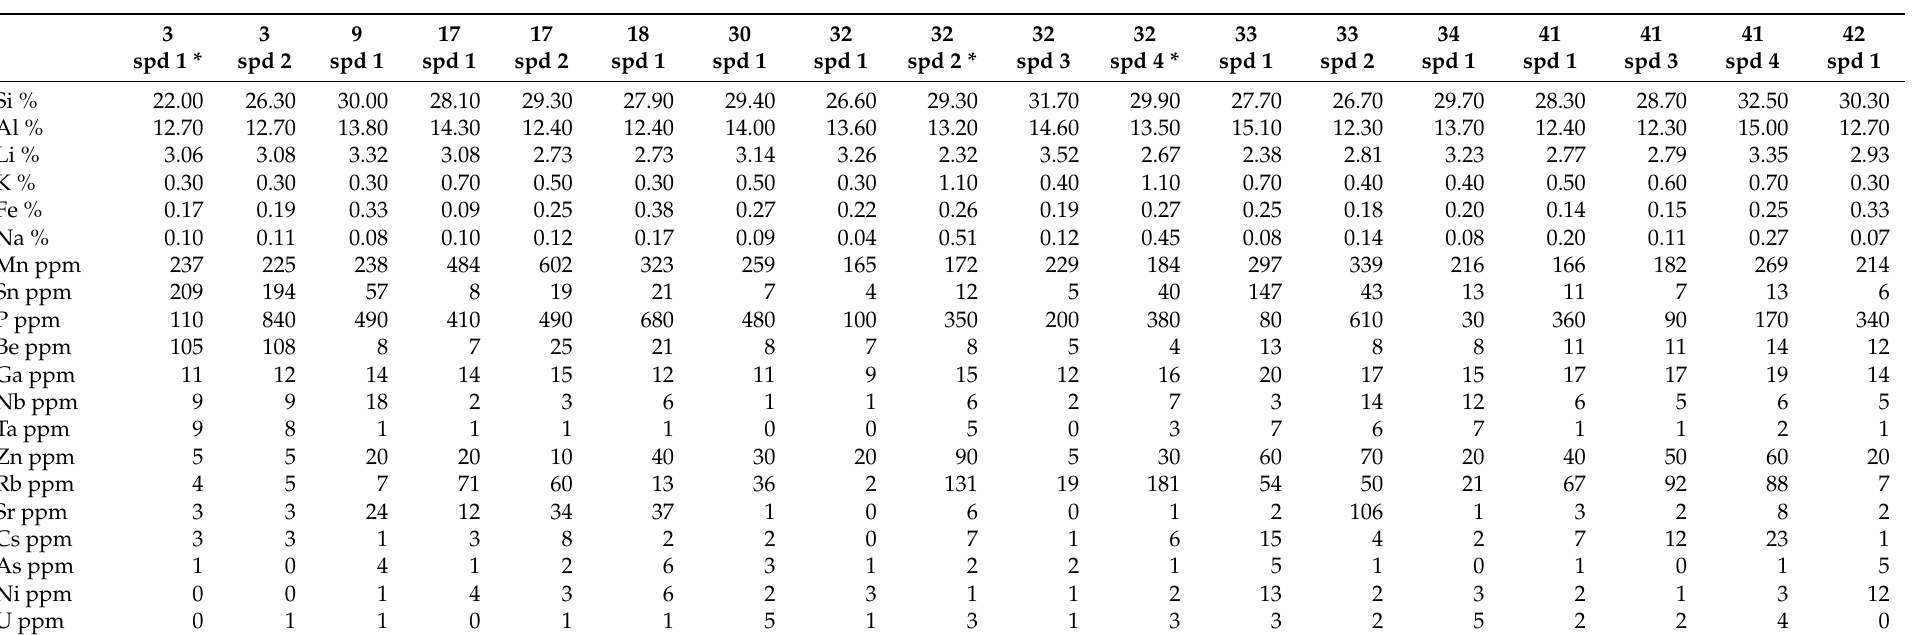
Table 1. Geochemical results of spodumene (spd) from the ICP-MS used on the “ Spd_Barroso ” and “ Fe_Barroso ” calibrations of the portable